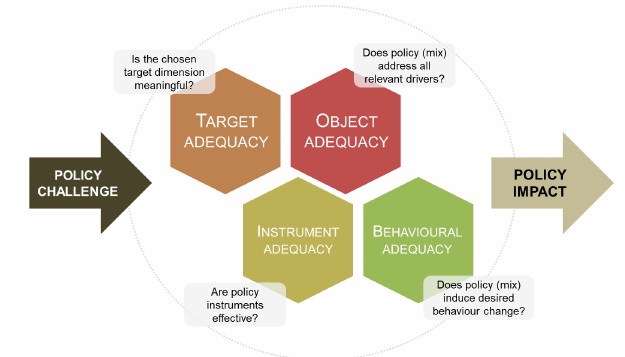
Figure 1. Governance disruptions framework (GDF) (modified af- ter Schröter-Schlaack and Hansjürgens, 2019, Fig.